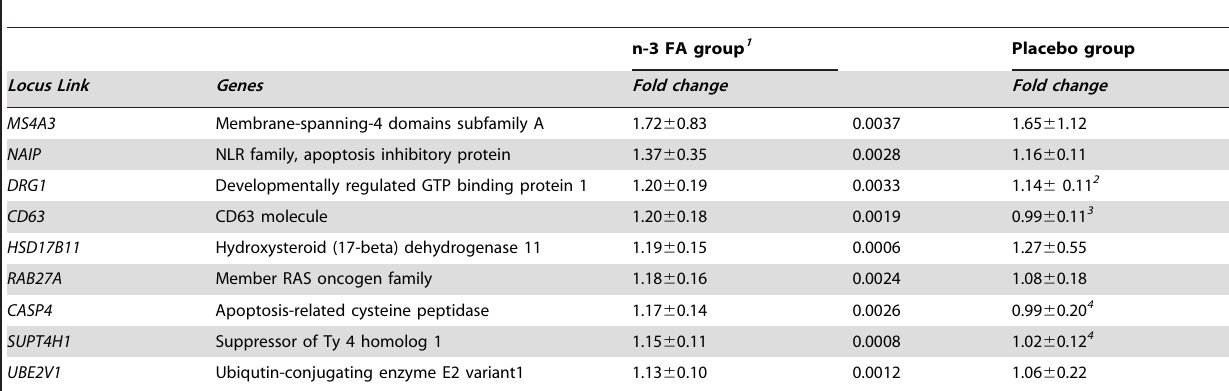
Table 1. Genes up-regulated by a DHA rich n-3 fatty acid or placebo